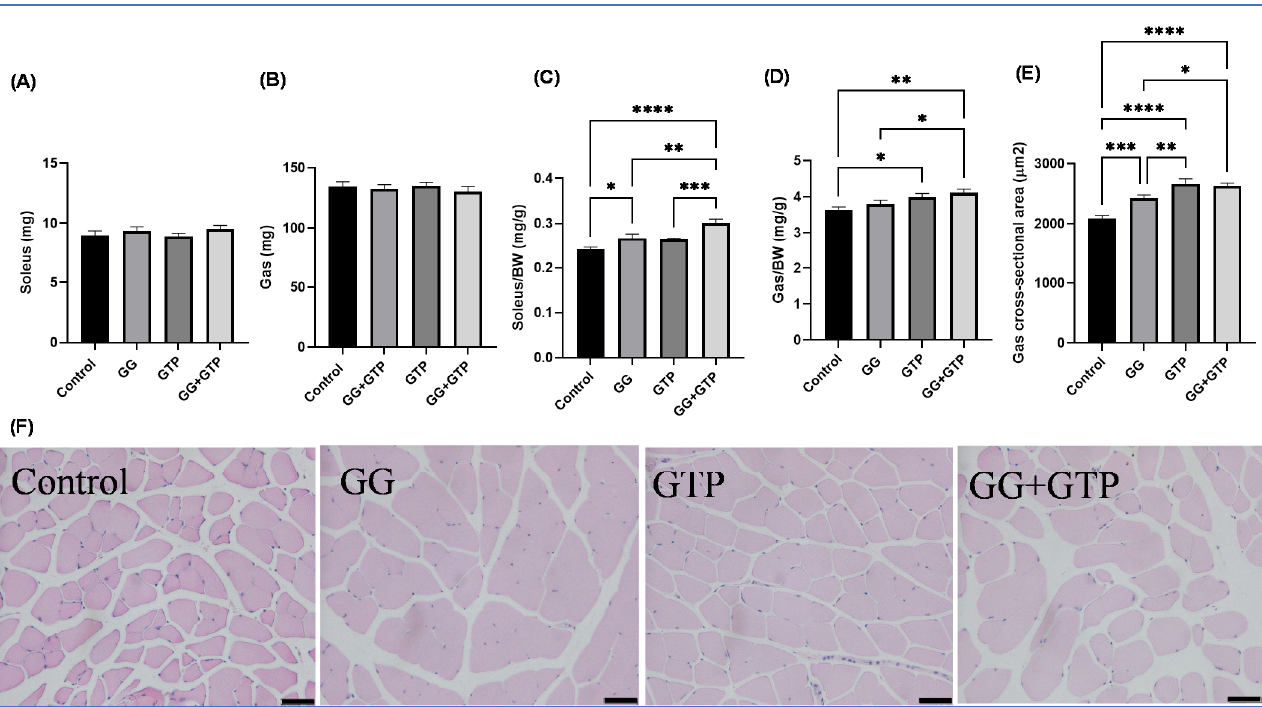
Figure 2. Effects of GGOH and GTPs on muscle morphology. ( A ) Soleus weight, ( B ) gastrocnemius weight, ( C ) soleus weight normalized by BW. ( D ) Gastrocnemius weight normalized by BW. ( E ) Gastrocnemius muscle CSA. ( F ) Representative images of control, GG, GTPs, and GG + GTPs gastrocnemius muscle sections stained with hematoxylin and eosin. The scale bar = 100 μ m. Over 2000 fibers per group were counted. BW, body weight; Control, HFD only; GG, HFD supplemented with GGOH in 400 mg/kg diet; GTPs, HFD supplemented with 0.5% weight/volume GTPs in water; GG + GTPs, HFD supplemented with a combination of GGOH and GTPs; *, p < 0.05; **, p < 0.01; ***, p < 0.001, and ****, p < 0.0001 by Fisher’s Least Significant Difference (LSD) test post hoc analysis.